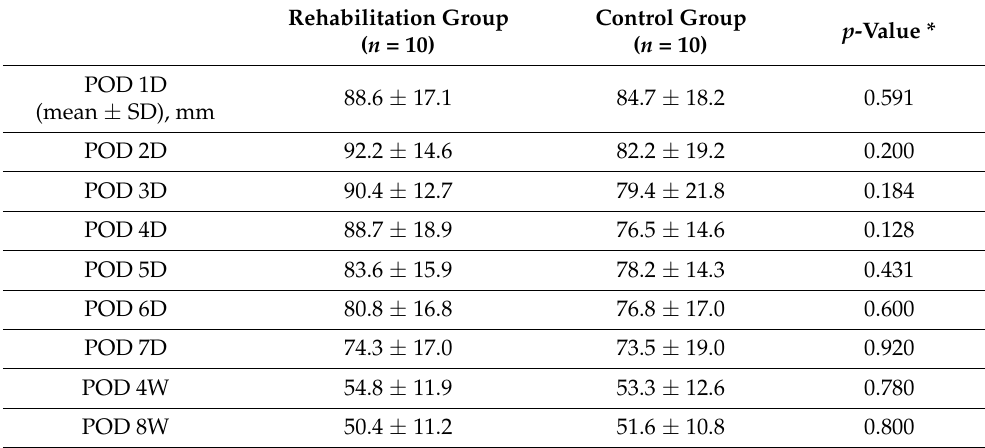
Figure 5. Dysphagia severity of patients in the laryngeal rehabilitation and control groups. POD, postoperative day; D, day; W, week. Table 5. Total variation and average of prevertebral soft tissue swelling on C-spine lateral